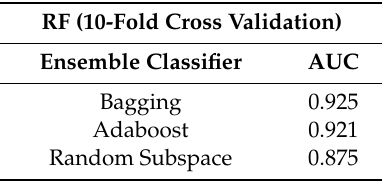
Table 9. AUC evaluation of ensemble with RF base classifier.